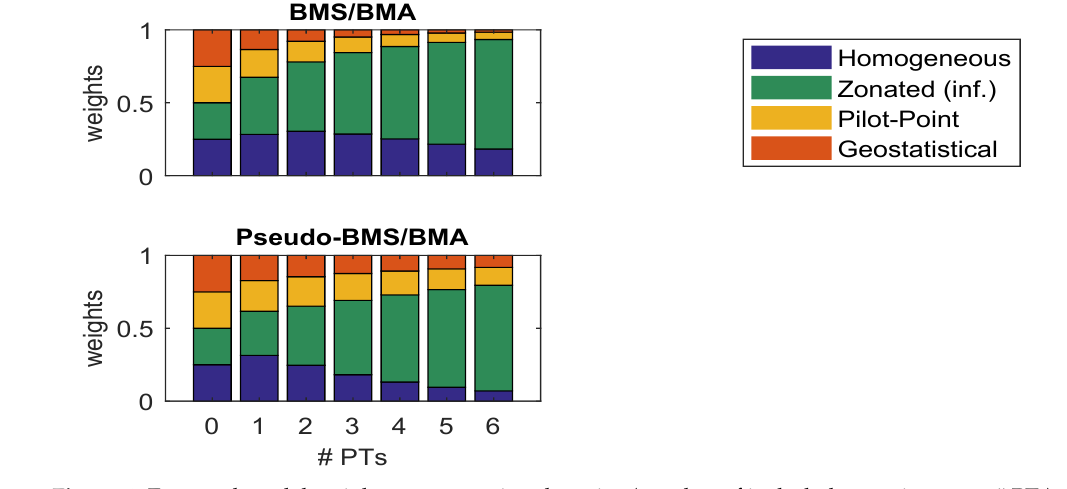
Figure 4. Expected model weights over growing data size (number of included pumping tests, # PTs) for the M -closed setting, i.e., with synthetic data generated by the informed zonated model (DGP). Top: BMS/BMA; bottom: